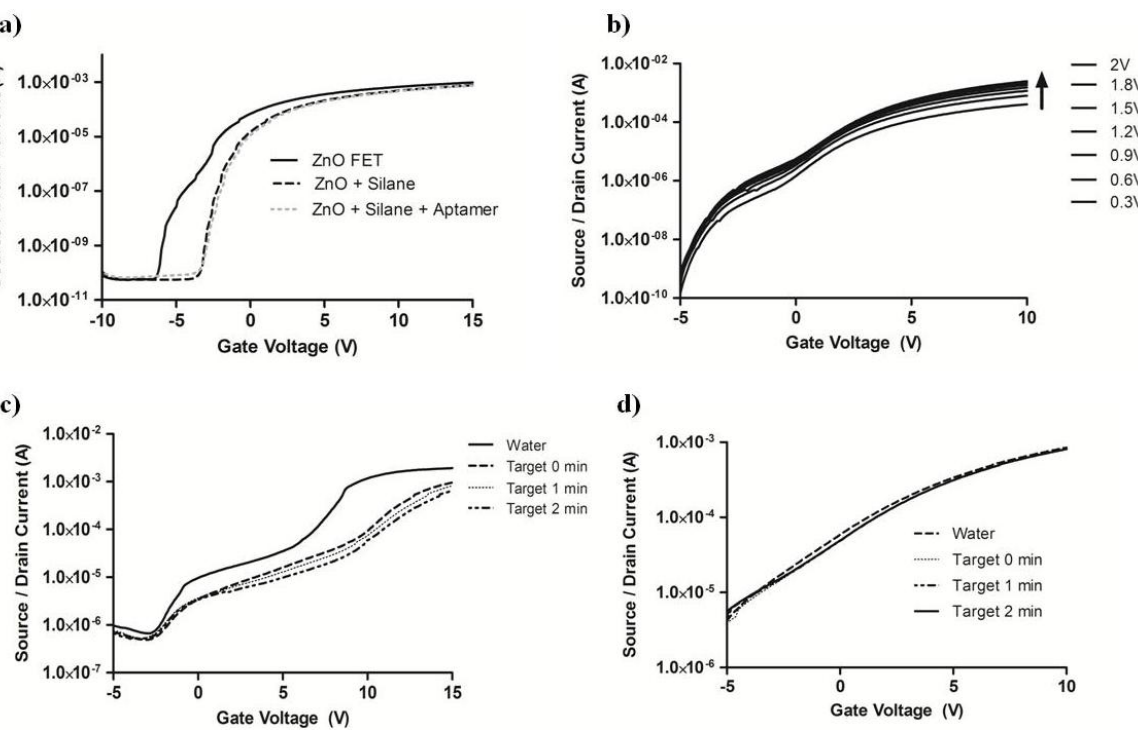
Figure 3. AptaFET device performance: ( a ) Source/Drain (I ) current versus Gate SD Voltage (V ) at a Source/Drain Voltage (V ) = 0.5 V for unfunctionalized ZnO-FET, G SD ZnO-FET with silane linker, and ZnO-FET with silane linker and aptamer, ( b ) I vs . V SD G with modulation of V . ( c ) I vs . V for conditions of water equilibrium, immediately SD SD G after exposure of 10 µM riboflavin, and time points of 1 min and 2 min after exposure. ( d ) Response of an unfunctionalized ZnO-FET after exposure to 10 µM